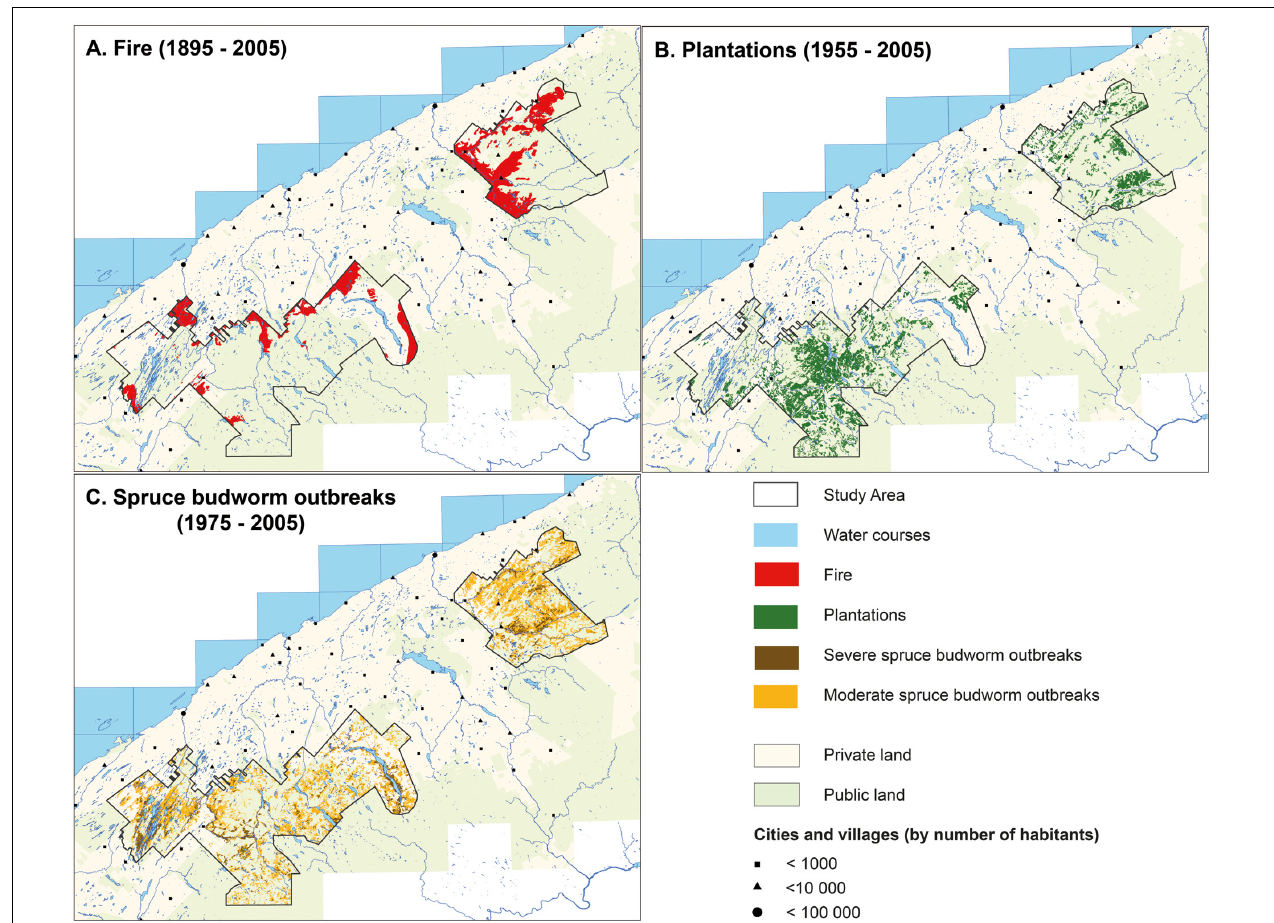
FIGURE 3 | Maps of fires (A) , plantations (B) , and spruce budworm outbreaks (C) disturbances in the Rimouski and Matane sectors.